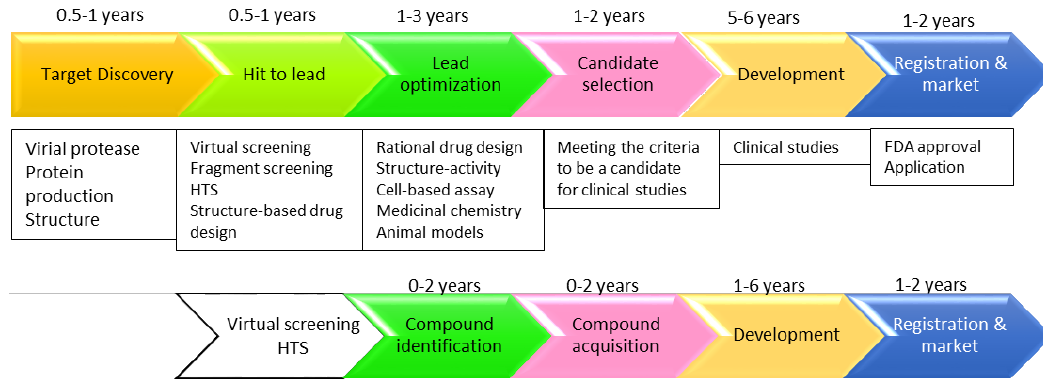
Figure 3. De novo drug discovery versus drug repurposing. The time required from hit identification to lead optimization ( upper panel ) is saved in drug repurposing ( lower panel ). In the case of SARS-CoV-2 3CL pro , virtual screening, biochemical, and cell-based assays were applied to identify protease inhibitors from FDA-approved drugs. The duration required in individual processes is based on [59], which gives detailed information for drug repurposing. It is worth mentioning that the timeline for COVID-19 might be di ff erent from other diseases due to its pandemic status. HTS, high throughput screening. FDA, the Food and Drug Administration.